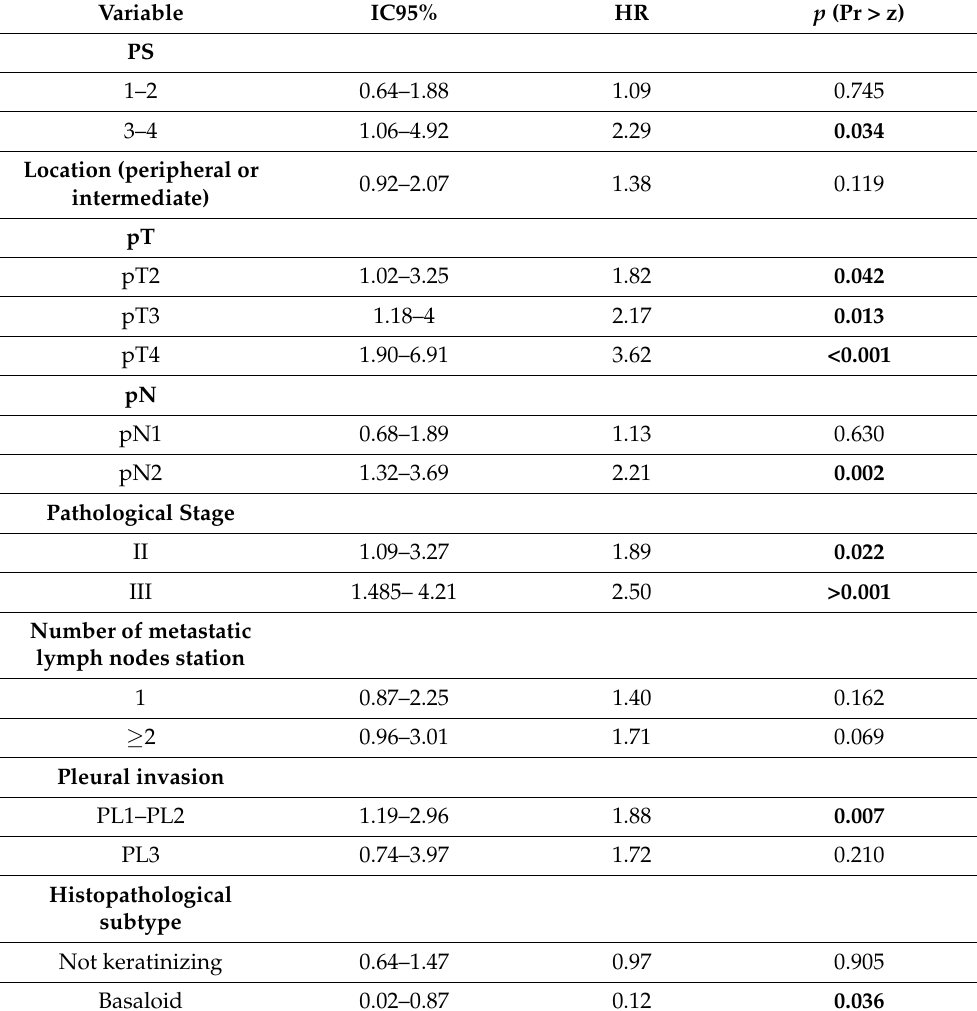
Table 3. Univariate analysis of survival for clinical and pathological